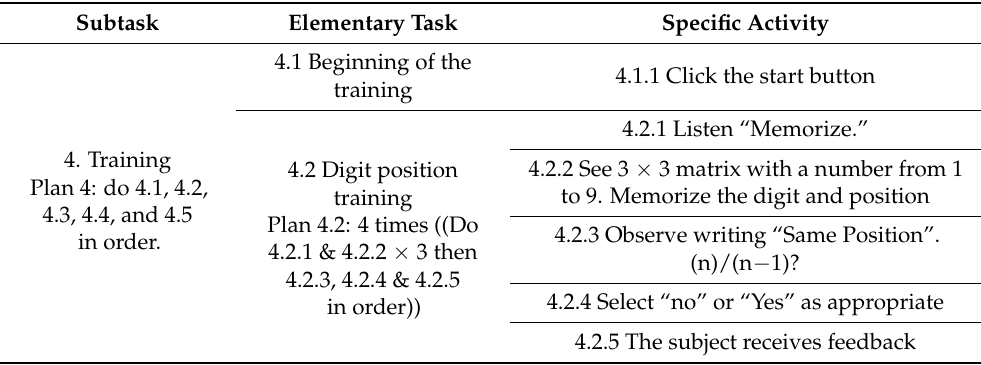
Table 2. Excerpt of the hierarchical breakdown into the list of sub-tasks, elementary tasks, and spe- cific activities.